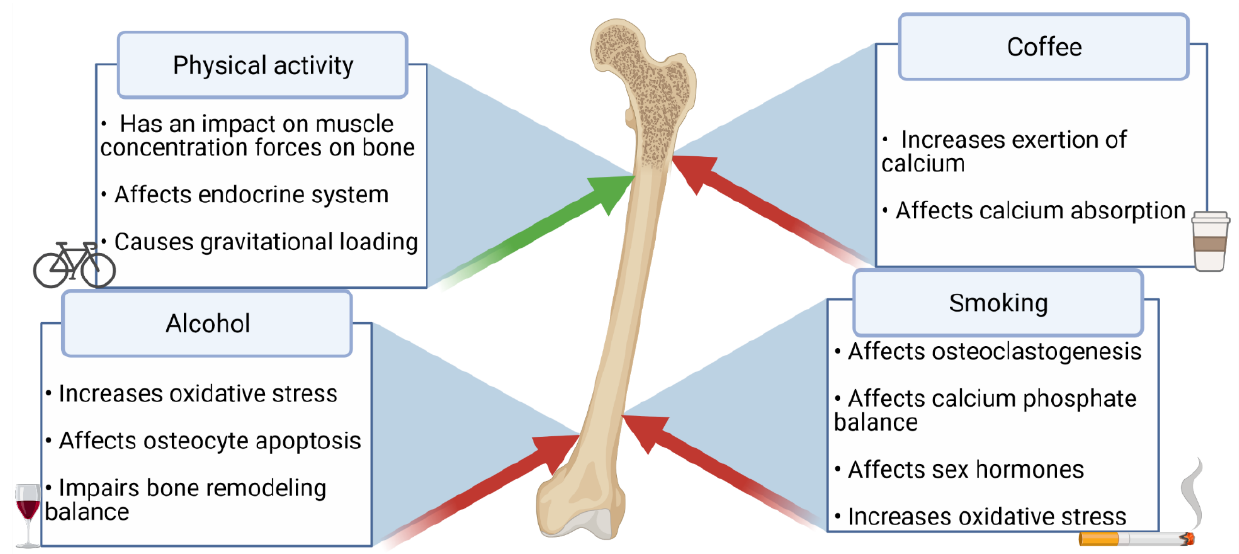
Figure 1. The impact of coffee, alcohol, smoking, and physical activity on BMD and the risk of osteoporosis.